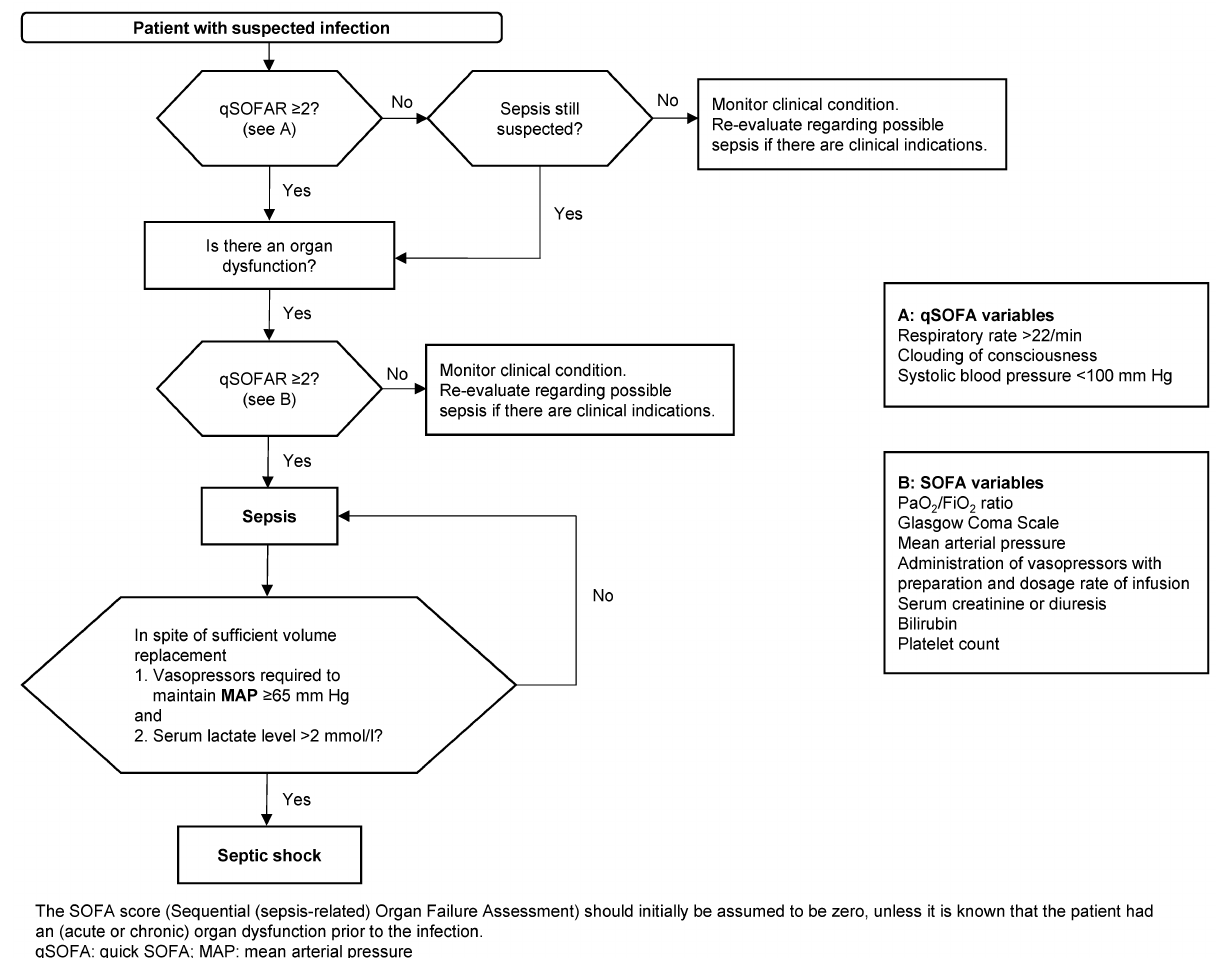
Figure 1: Flowchart to identify patients with sepsis and septic